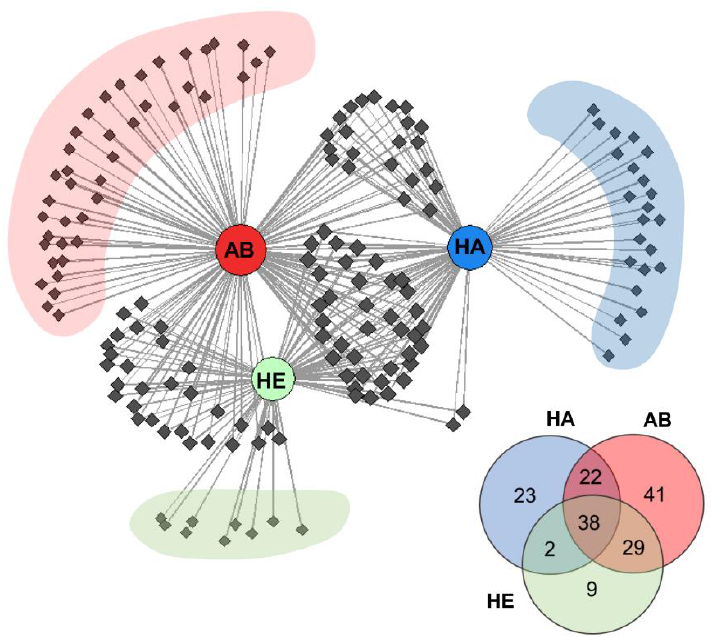
Figure 2. Correlation networks of VOCs emitted from saliva samples from all three group of patients, where: healthy patients (HE), subjects with submandibular abscesses (AB) and halitosis (HA). VOCs are shown as nodes. Numbers in circles denote the number of volatiles from each group.